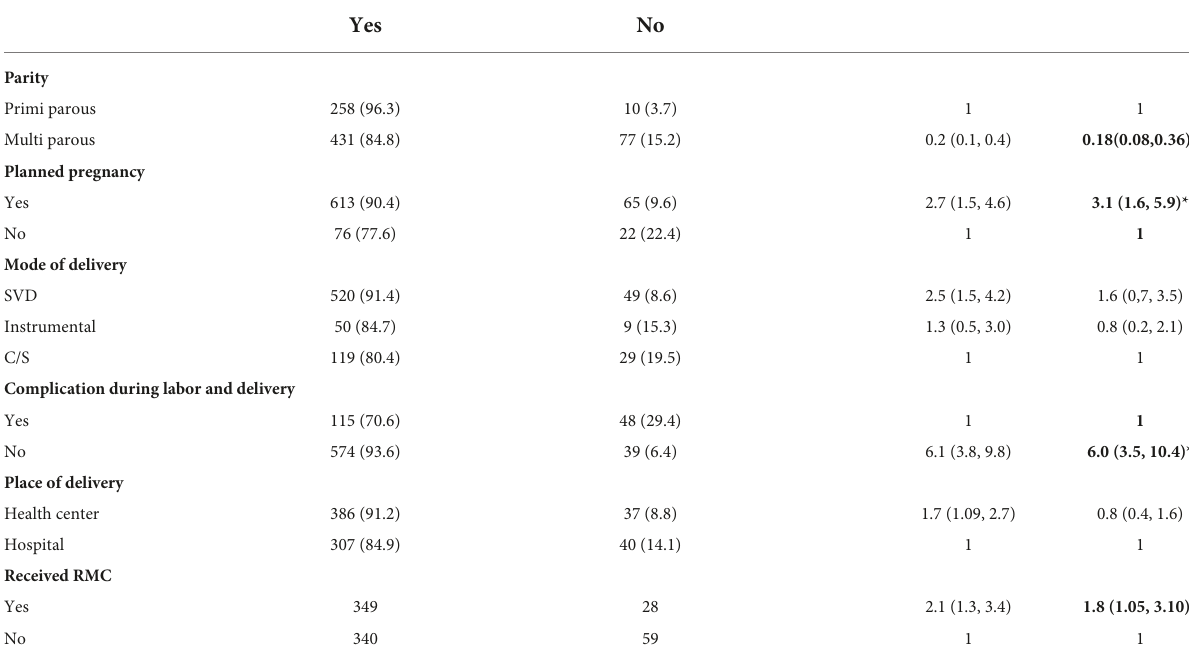
TABLE 3 Logistic regression